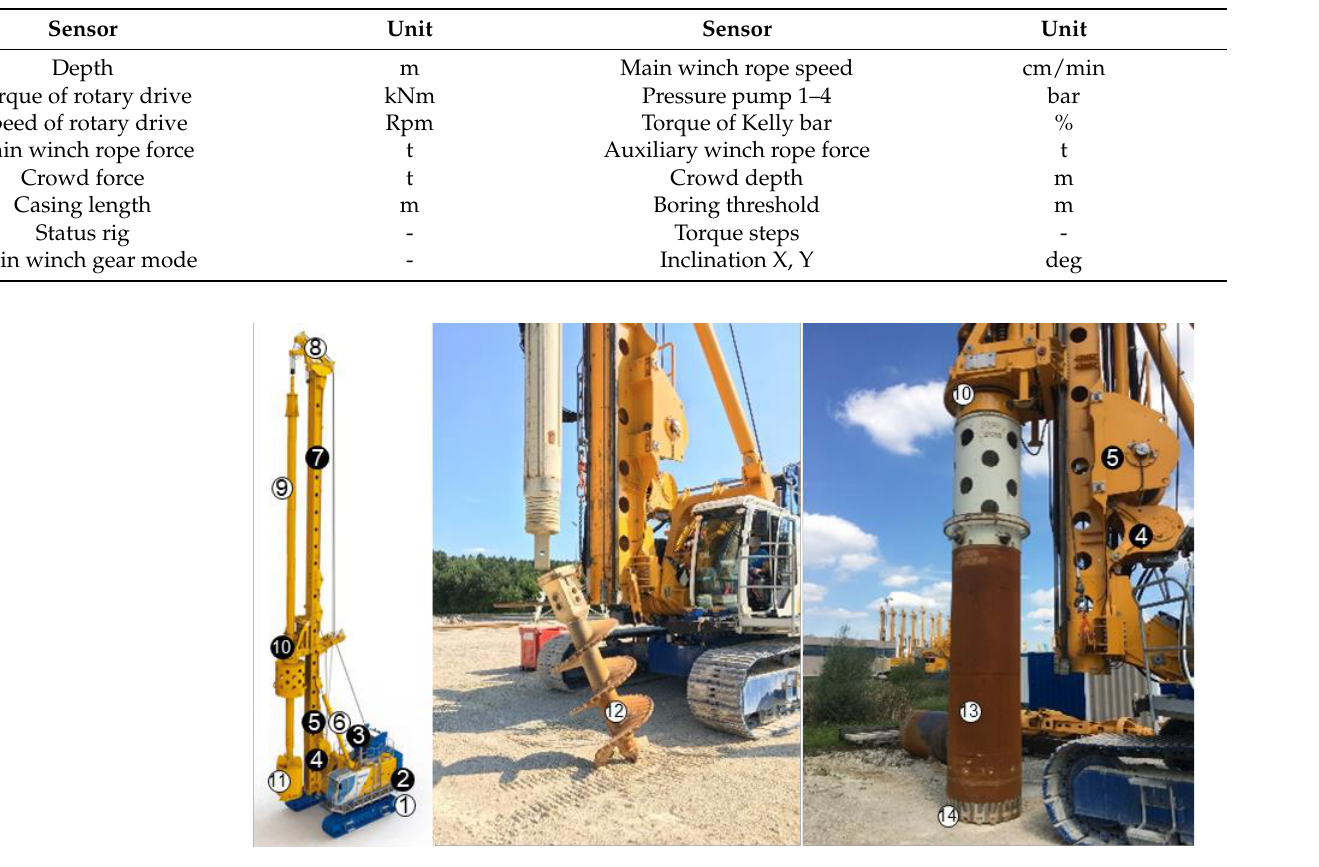
Figure 3. Rotary drilling rig at the test site of Bauer Group in Schrobenhausen, Germany (pictures by Fischer, A.); components (number in white circle) and sensors (black circles): (1) under